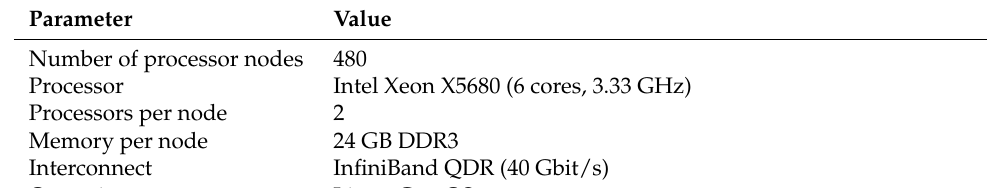
Table 1. Specifications of the “Tornado SUSU” computing cluster.